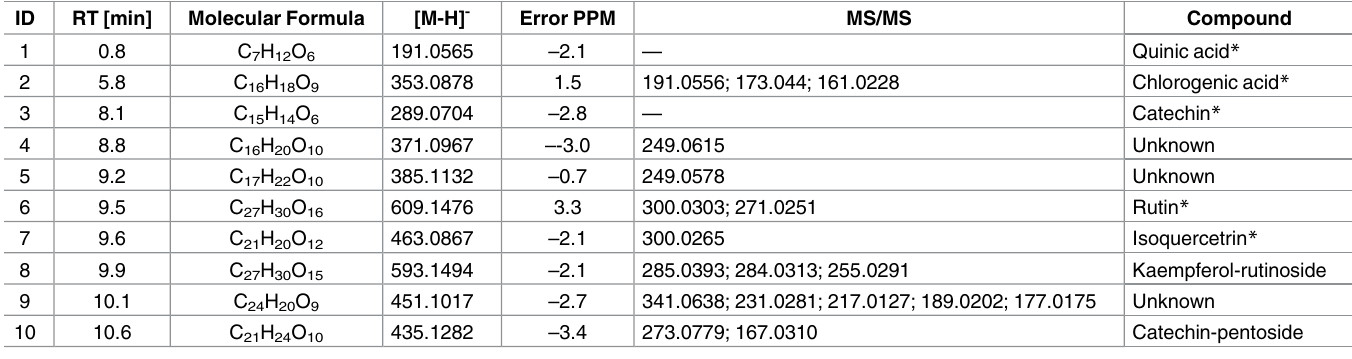
Table 1. Phenolic compounds identified from the HPLC-DAD-MS/MS of the ethanolic extract of Hancornia speciosa